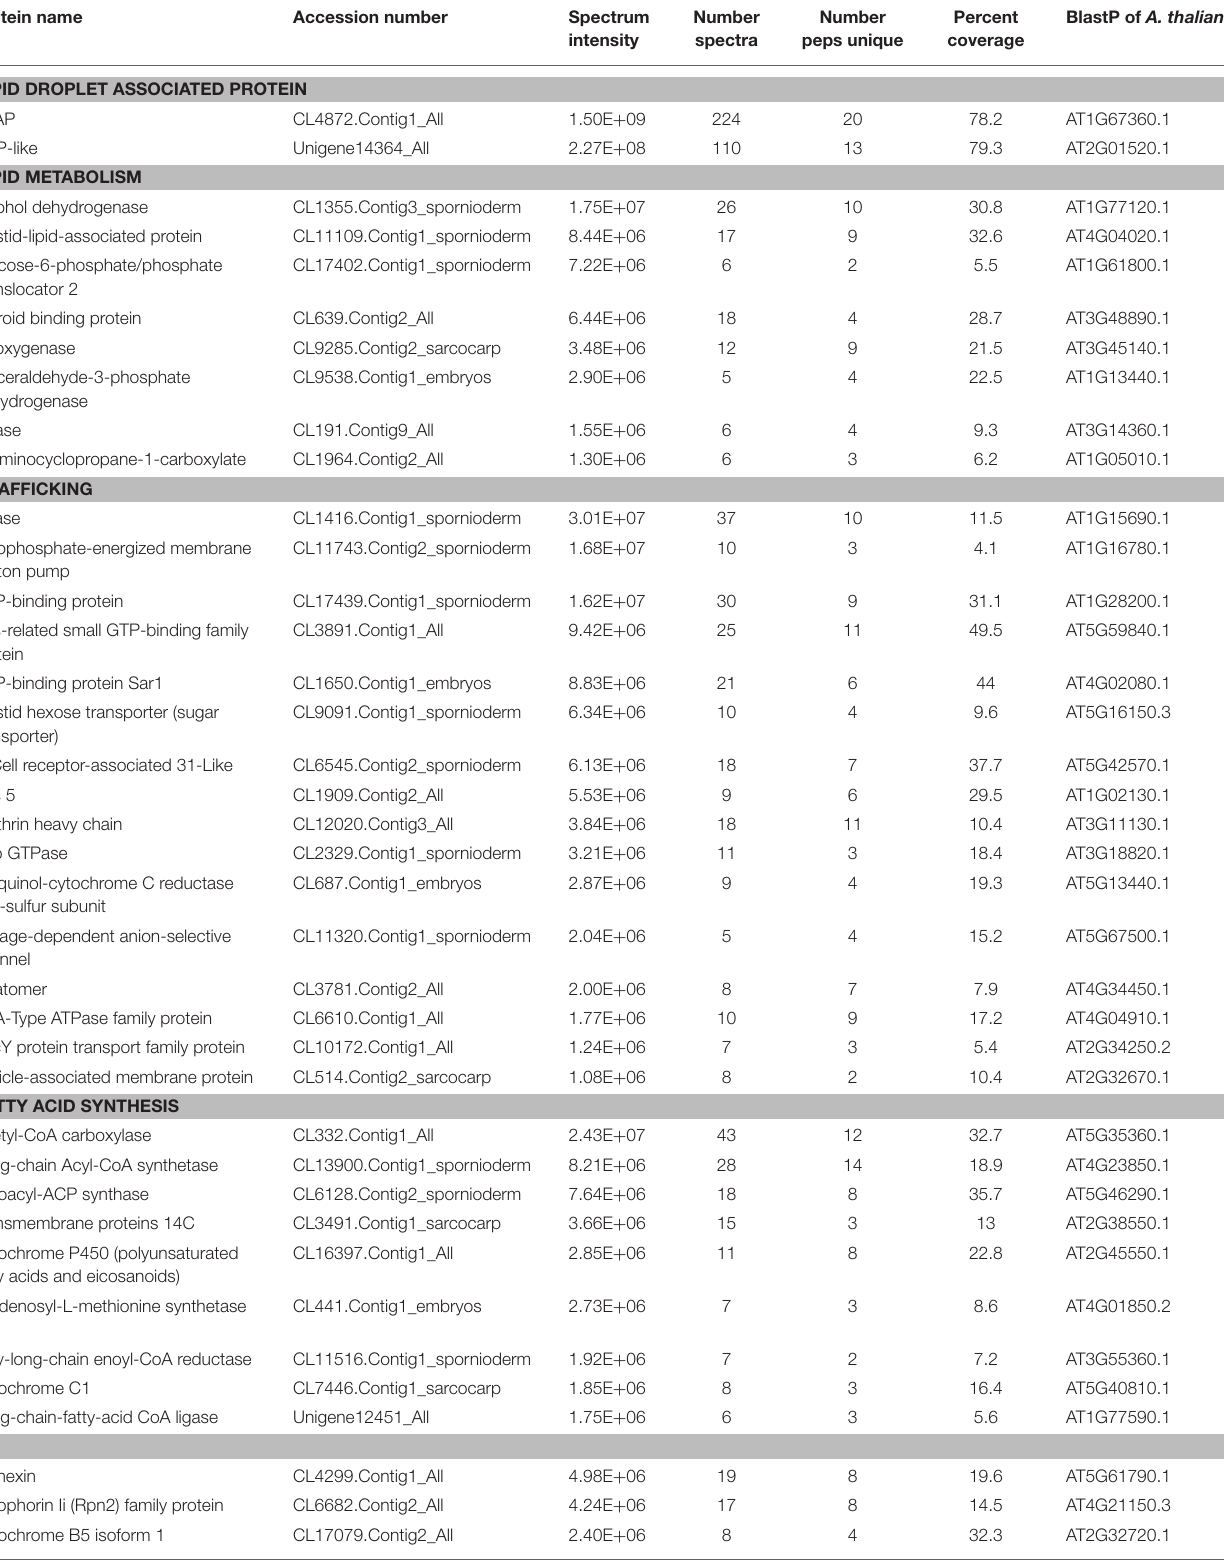
TABLE 2 | Proteins identified (with intensity over E + 06) from LDs purified from mesocarp of Triadica